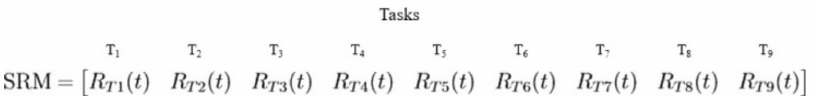
Figure 26. System Reliability Matrix (SRM) of the example